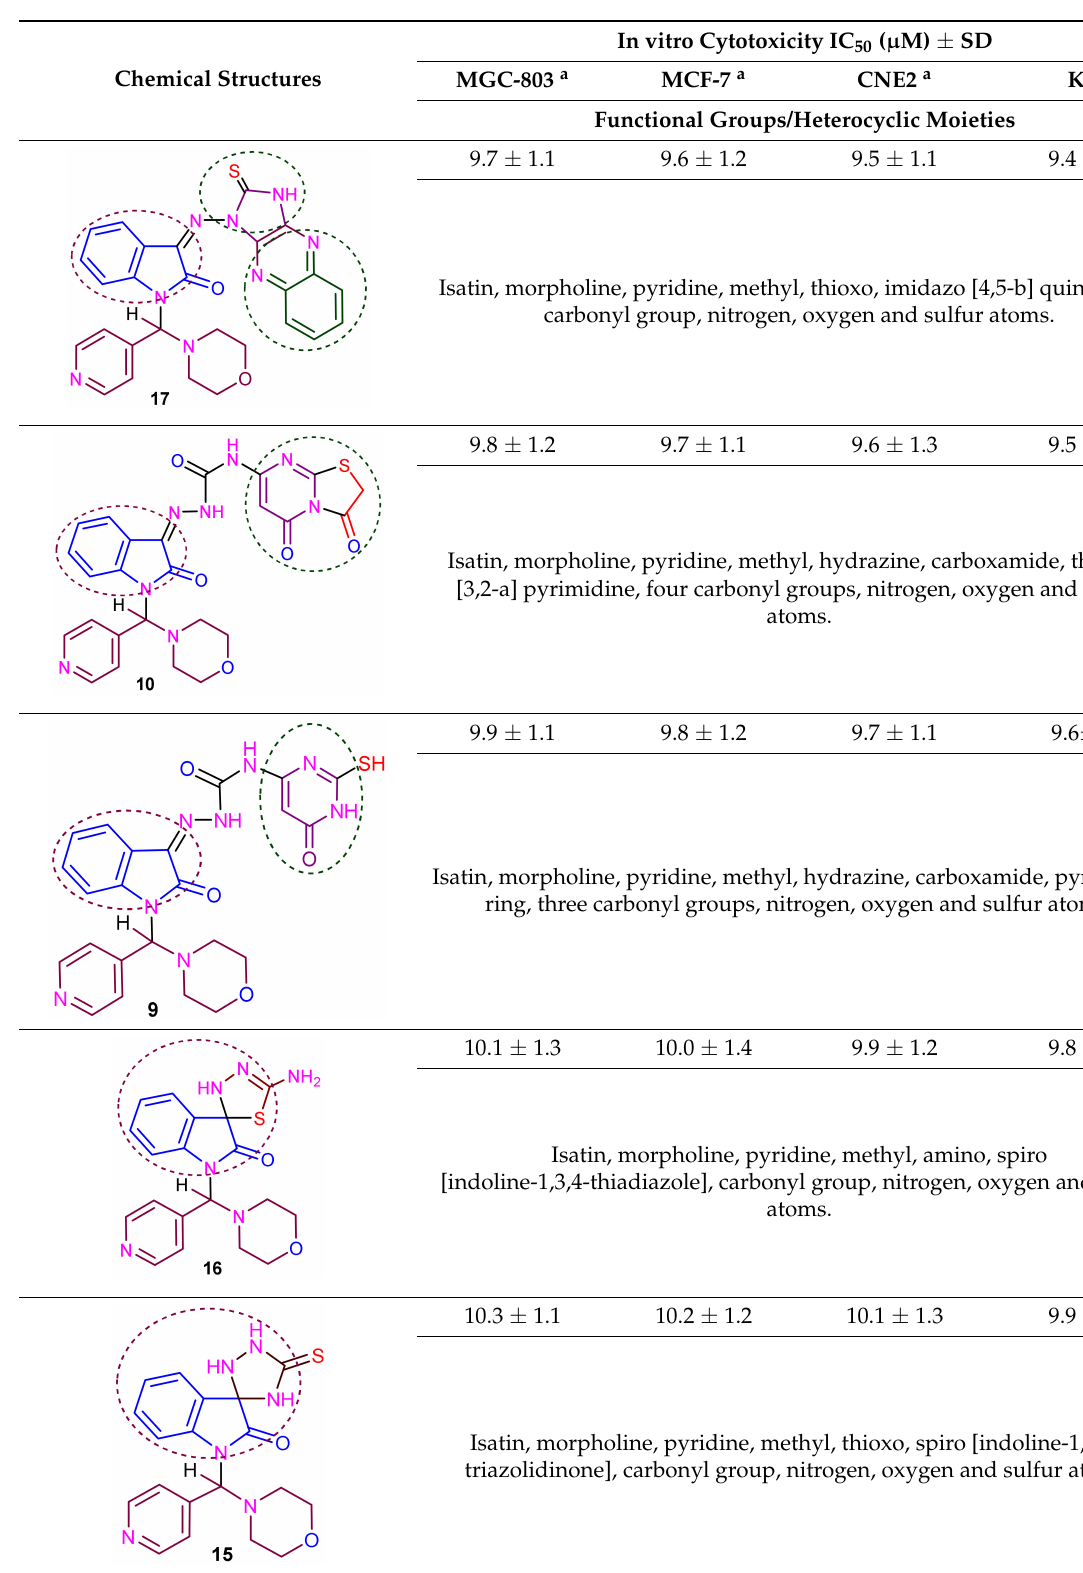
Table 2. The best new isatin derivatives with cytotoxic activity against different human cancer cell